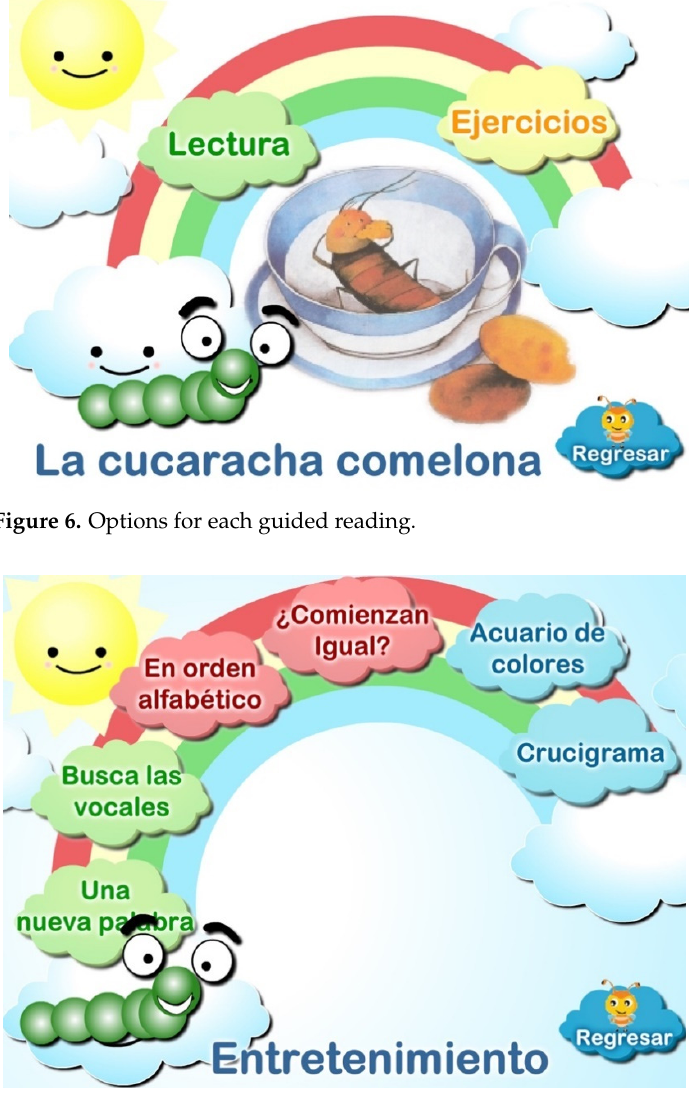
Figure 7. Play activities of the application. Table 7. Description of techniques used in the Test or Evaluate